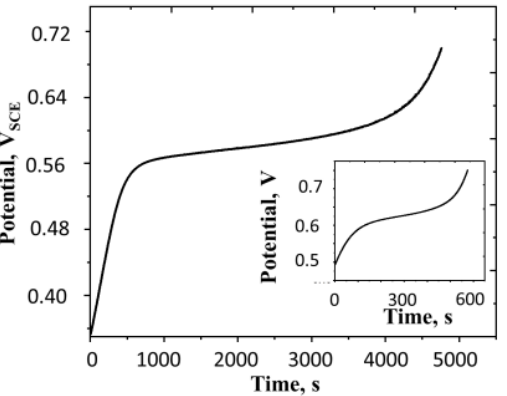
Figure 9. Anodic chronopotentiogram of polyaniline film at constant current density of 2.50 A m −2 . Surface aerated system, concentration of H 2 SO 4 = 0.5 M, surface mass density of the film = 16.3 g m −2 and temperature = 25 °C. All potentials are reported with respect to SCE. The inset shows the chronopotentiogram for the same film at the current density of 7.5 A m −2 under otherwise identical conditions.